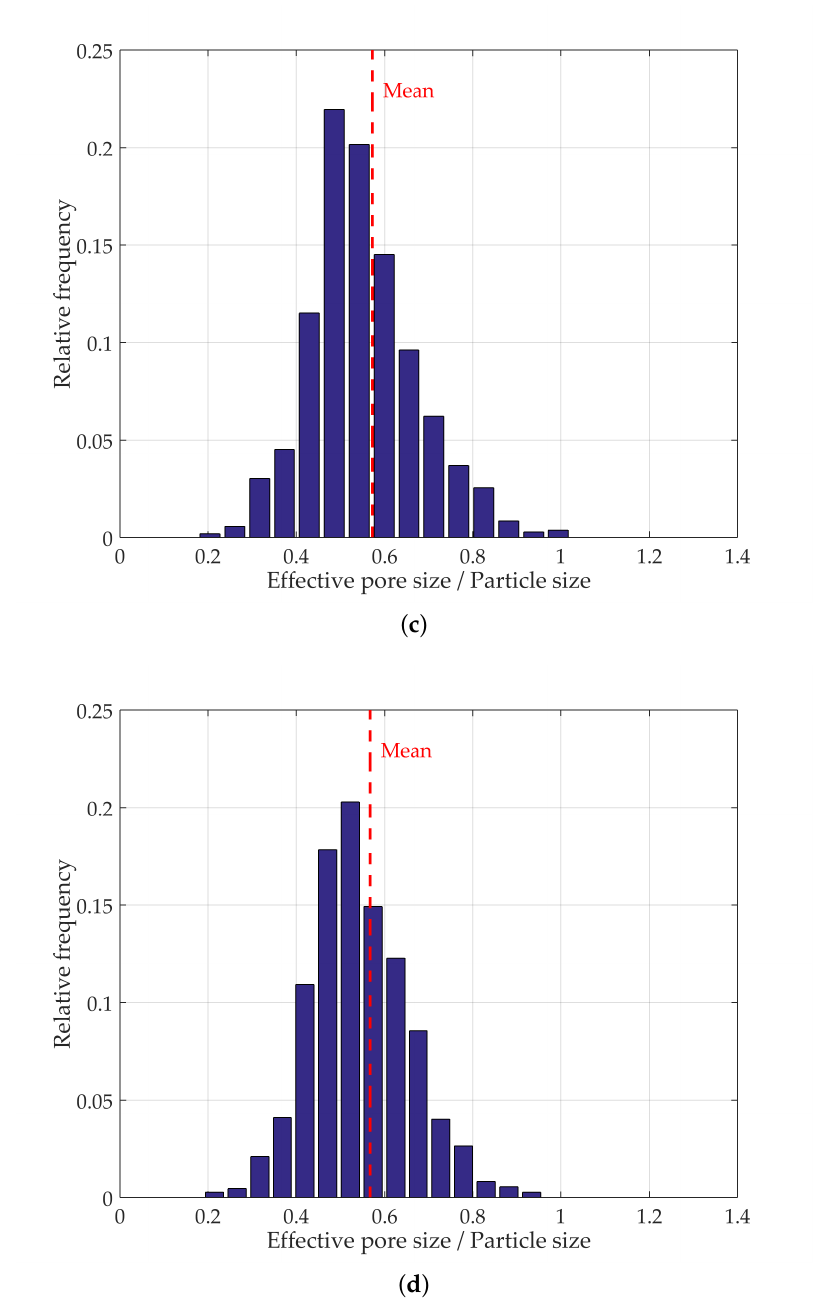
Figure 11. PSD in four different models suggested by Dullien [43]. ( a ) very loose packing; ( b ) loose packing; ( c ) pouring packing; ( d ) dense random packing. The mean effective normalized pore size for four different granular specimens are 0.567 (dense random packing), 0.572 (poured random packing), 0.584 (loose random packing), and 0.621 (very loose random packing), as presented in Figure 11. These results highlight the effectiveness of the proposed method in characterizing the pore space and revealing the effects of underlying structural changes. Figure 12a,b illustrate the segmented pore space of both dense and very loose packings, respectively, where the overall contrast in pore size is